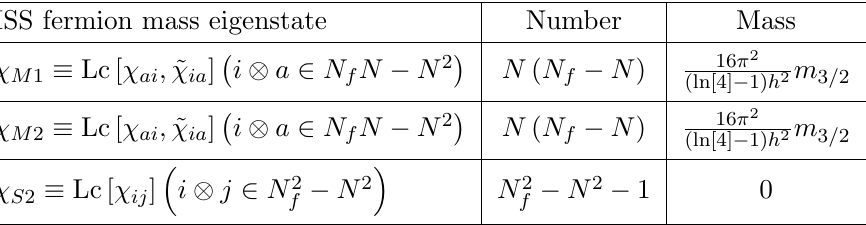
Table 3 . Leading order contributions to the masses of the ISS fermion eigenstates within the index space i (cid:10) a 2 N f N (cid:0) N 2 and i (cid:10) j 2 N 2 (cid:0) N 2 . The notations i (cid:10) a and i (cid:10) j are of the same type f as the ones for the ISS scalar masses table 1. Furthermore, Lc stands for the linear combinations given from equations (2.58) to (2.61), and the second column gives the number of ISS fermions mass eigenstates in the considered index